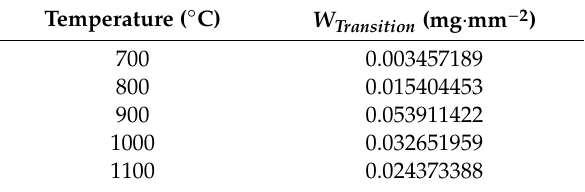
Table 7. The values of W Transition of the alloy at di ff erent